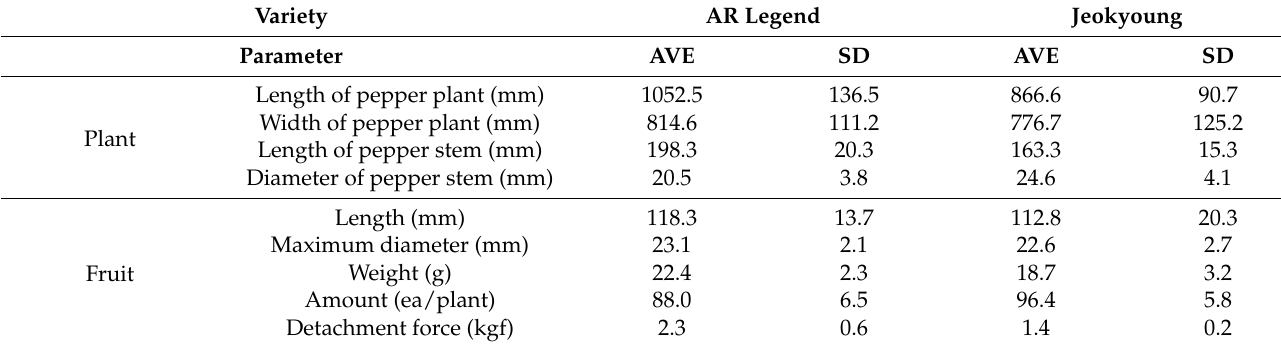
Table 2. Average (AVE) and standard deviations (SD) of the physical properties for peppers.